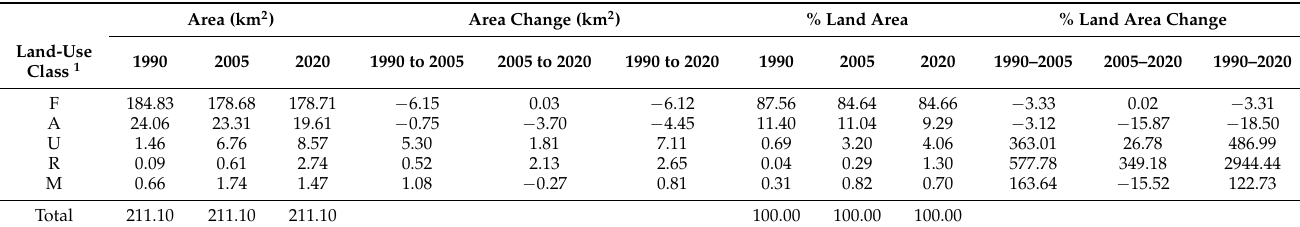
Table 3. Land-use area statistics in Koh Chang in 1990, 2005, and 2020 (km 2 ). Area (km 2 ) Area Change (km 2 ) % Land Area % Land Area